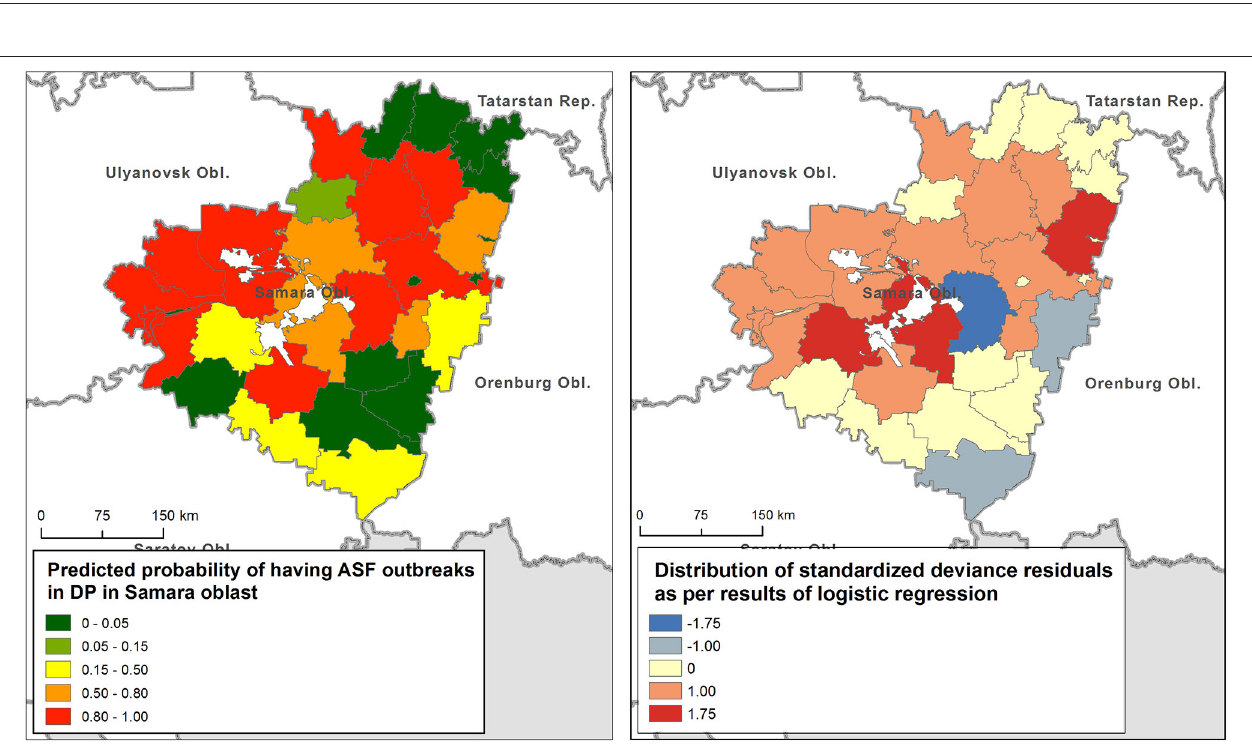
FIGURE 4 | Predicted probability of having an African swine fever (ASF) outbreak in domestic pigs (DP) in the Samara oblast (left), and the distribution of deviance residuals (right).